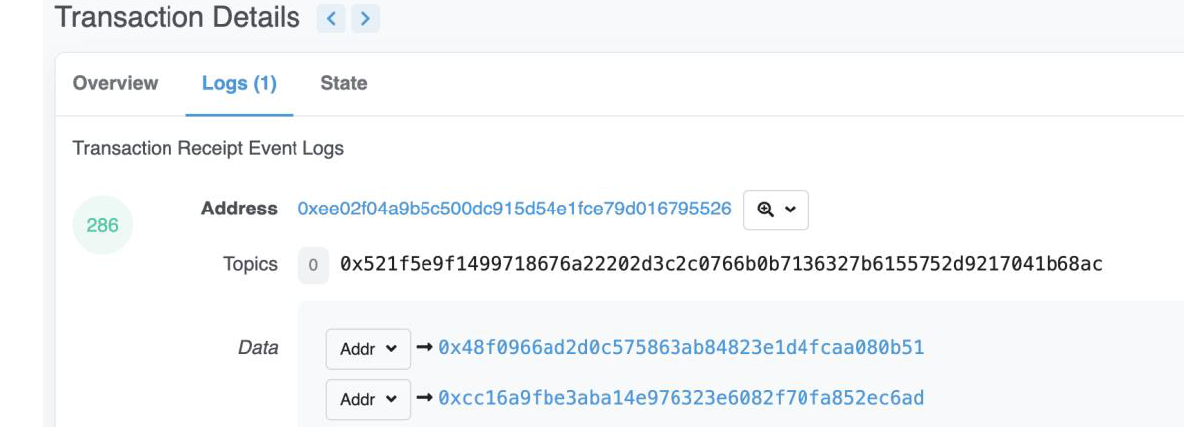
Figure A14. Logs of transferring CT transaction on Etherscan.